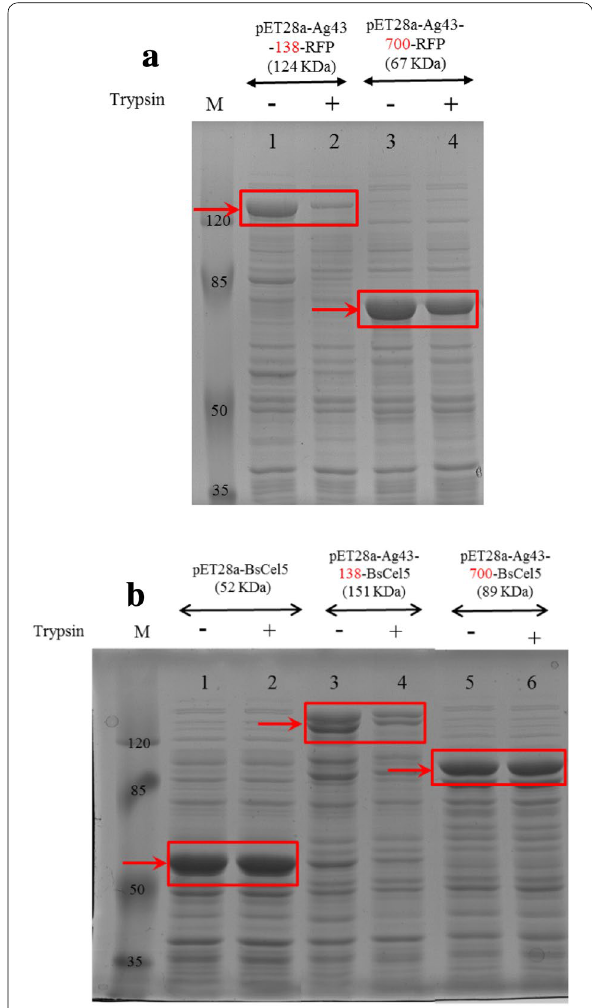
Fig. 4 Whole‑cell protease treatment analysis. a The whole‑cell SDS‑PAGE analysis of protease treatment ( ) and non‑treatment ( ) + − for RFP. b The whole‑cell SDS‑PAGE analysis of protease treatment ( ) + and non‑treatment ( ) for BsCel5. M indicates a protein marker. The − red arrows and boxes indicate the recombinant